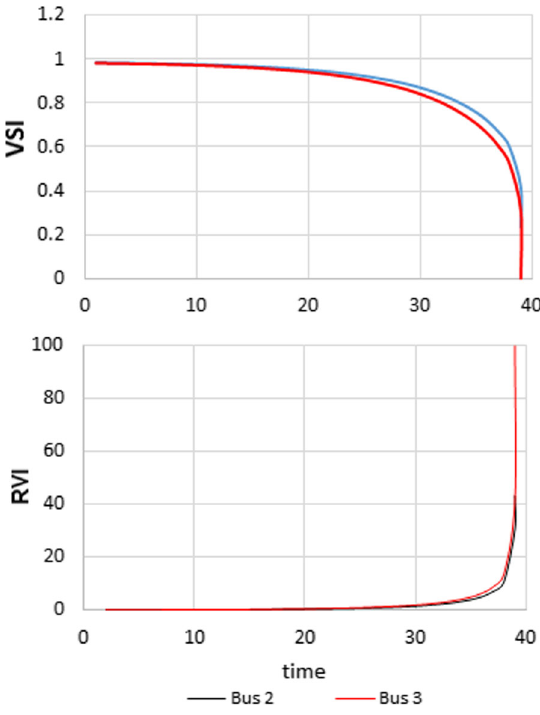
Fig. 11 VSI and RVI on MC load rise